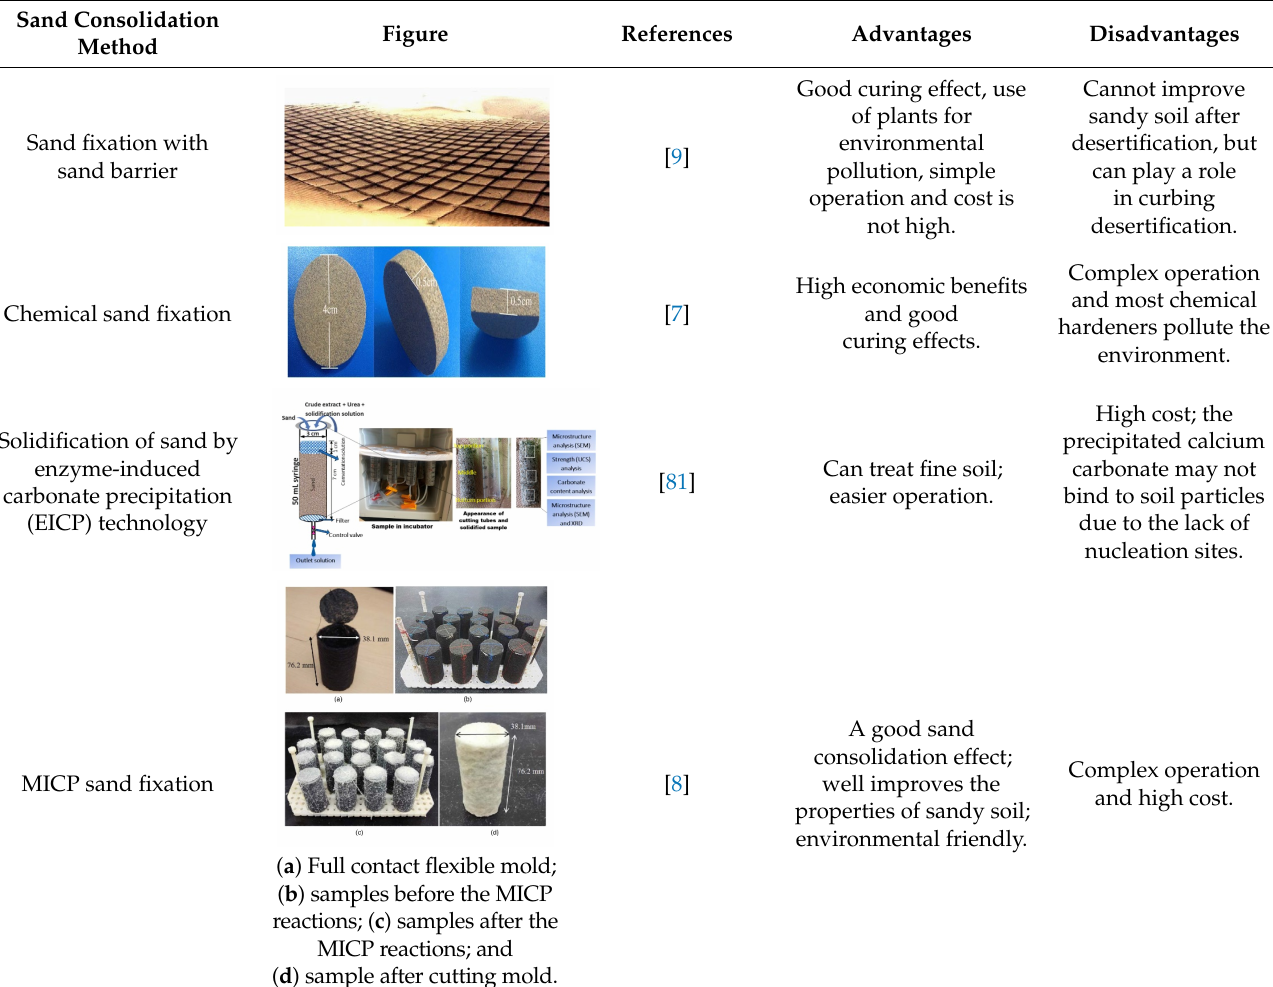
Table 3. Comparison of advantages and disadvantages of various sand consolidation